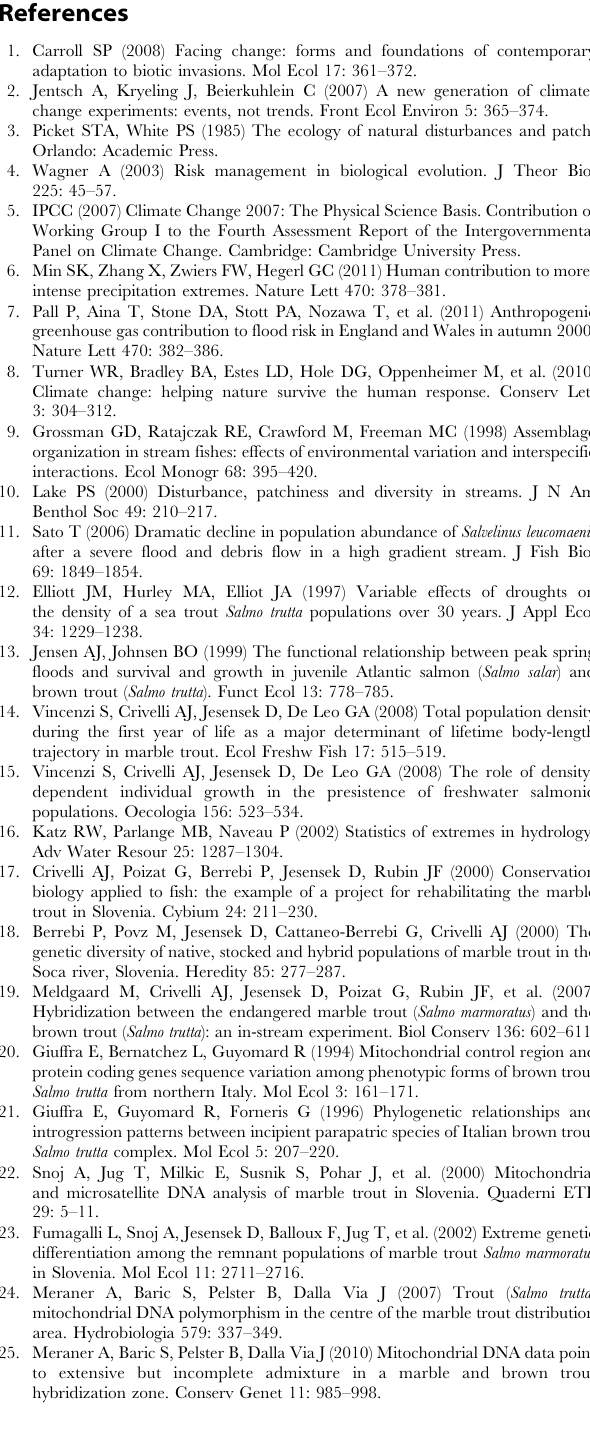
Table S1 Allele frequencies at all loci. Samples labelled as in Table